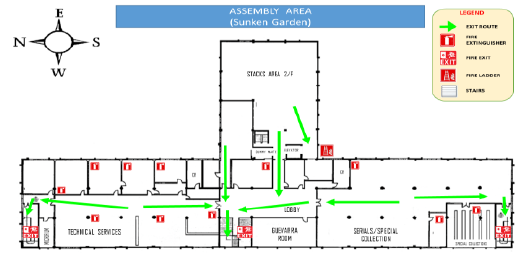
Figure 14. Currently Implemented Evacuation 2nd Floor Routes